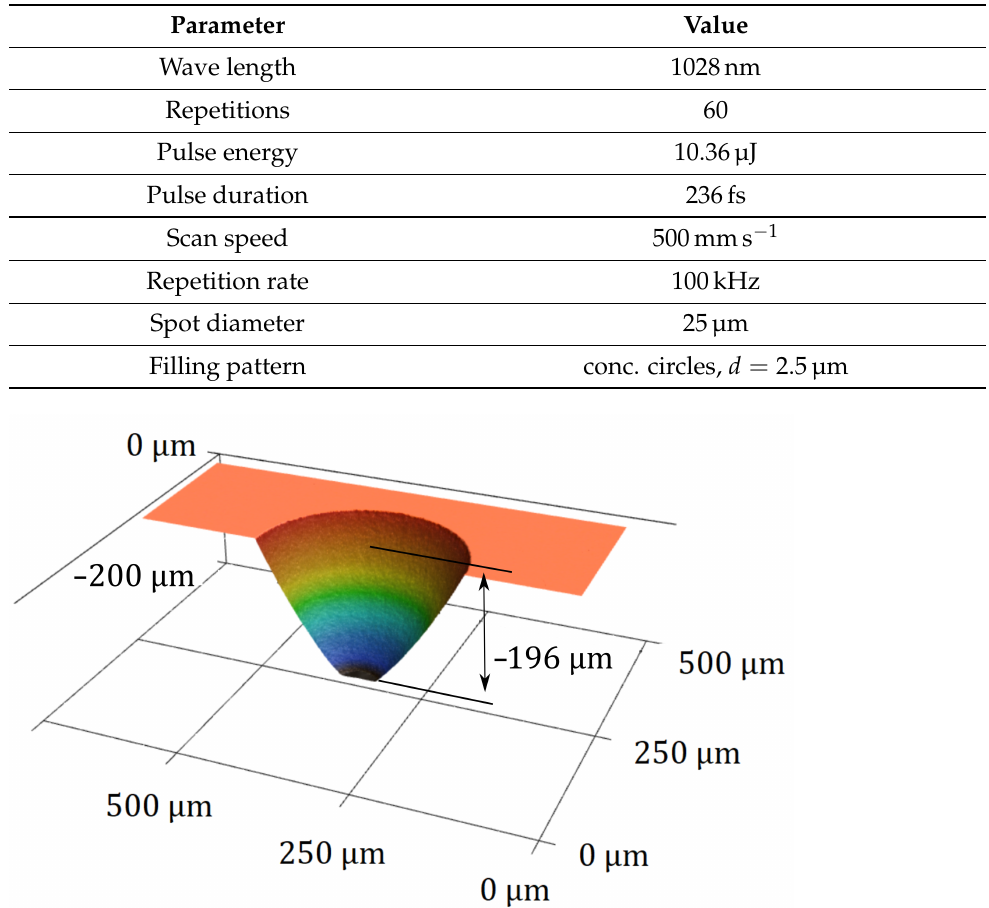
Figure 5. 3D profile of a through hole produced by means of femtosecond laser ablation and consecutive smoothing obtained with a laser scanning microscope (VK-X260K, Keyence, Osaka, Japan).